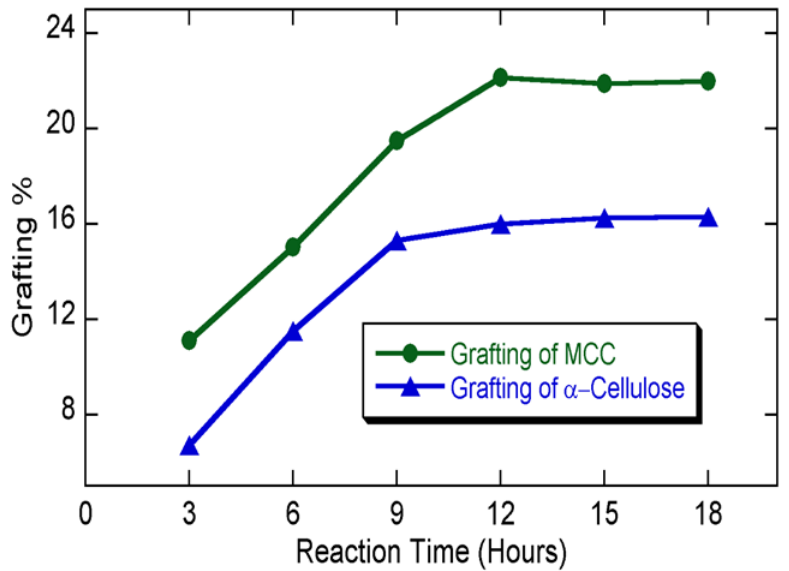
Figure 3. Grafting percentages of OLLA onto α -cellulose and MCC at different reaction time.